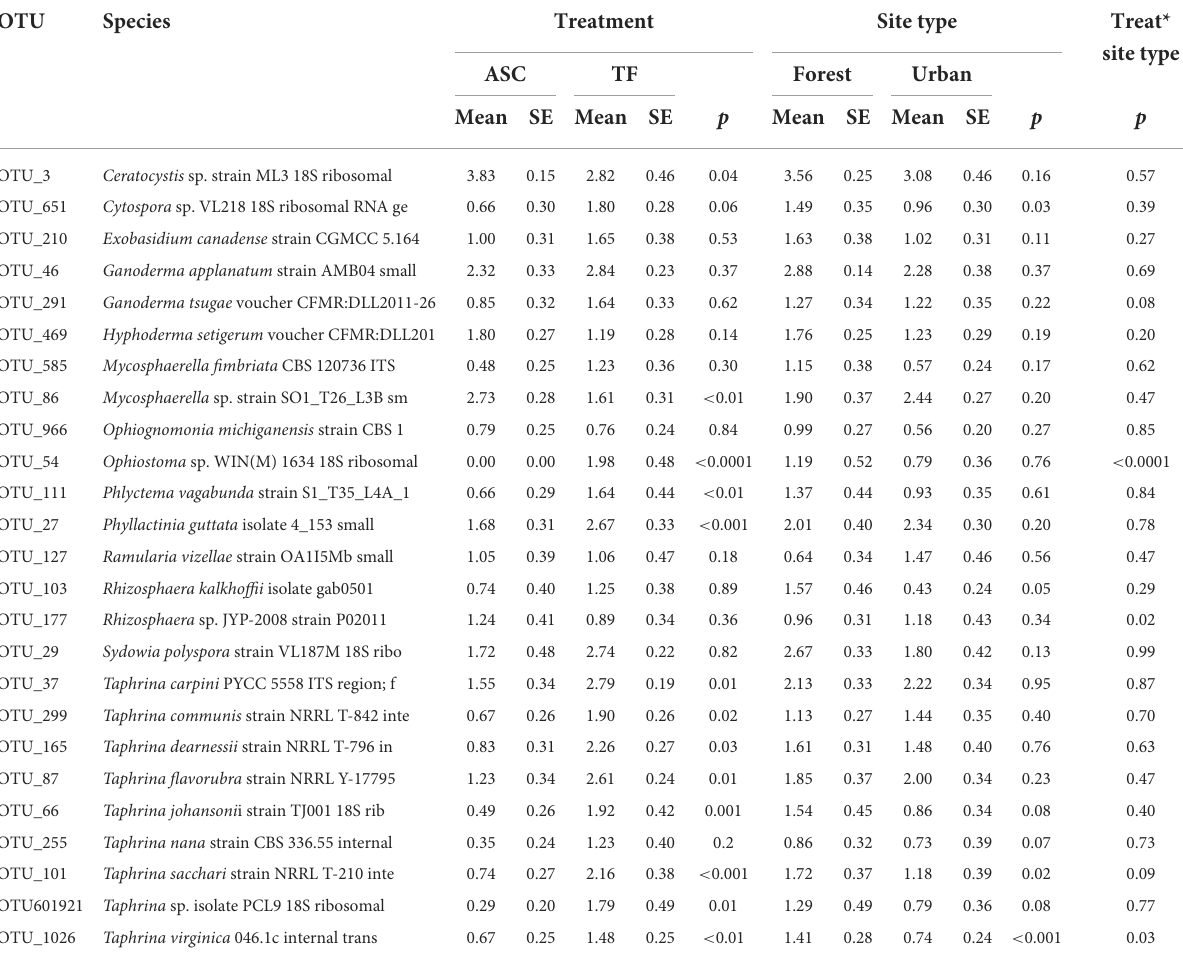
TABLE 2 Mean ( ± SE) abundance (DNA reads, log-transformed) of 25 of the 101 forest pathogens captured in aerial spore collectors (ASC) vs. Lindgren funnel trap fluids (TF), in forest vs. urban sites in New Brunswick, Nova Scotia, and Ontario, in 2018. OTU Species Treatment Site type Treat* site type ASC